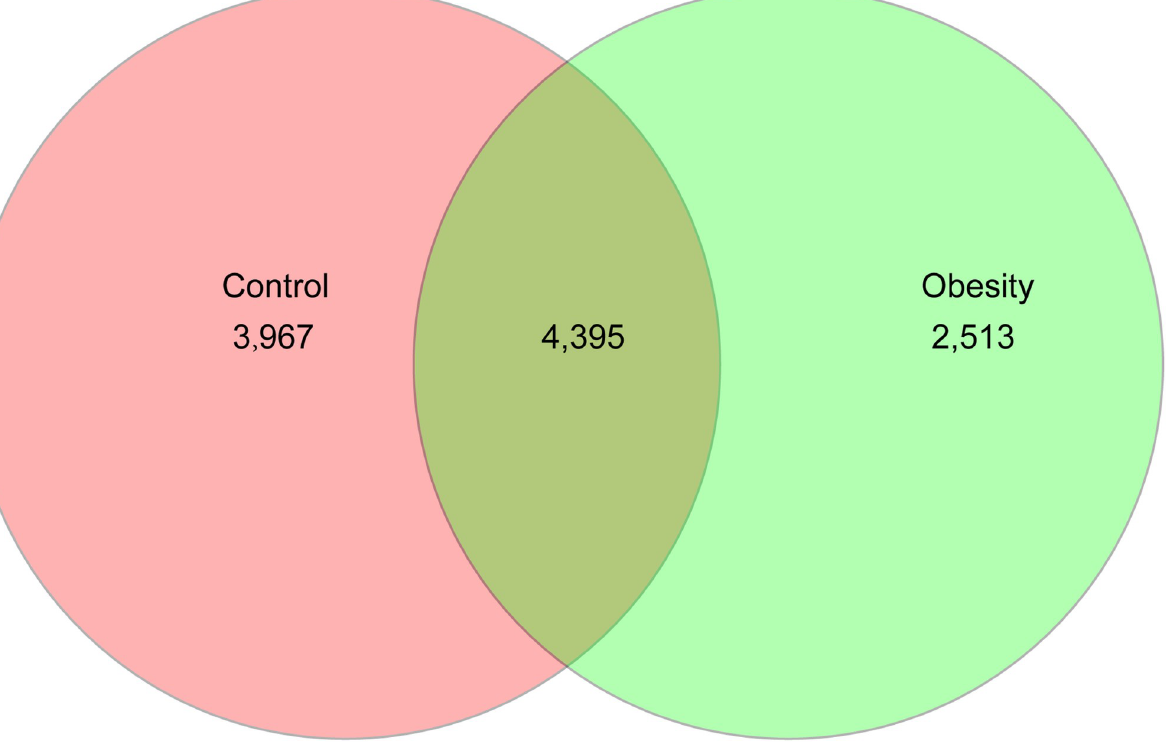
PLOS ONE | https://doi.org/10.1371/journal.pone.0255446 August 10,